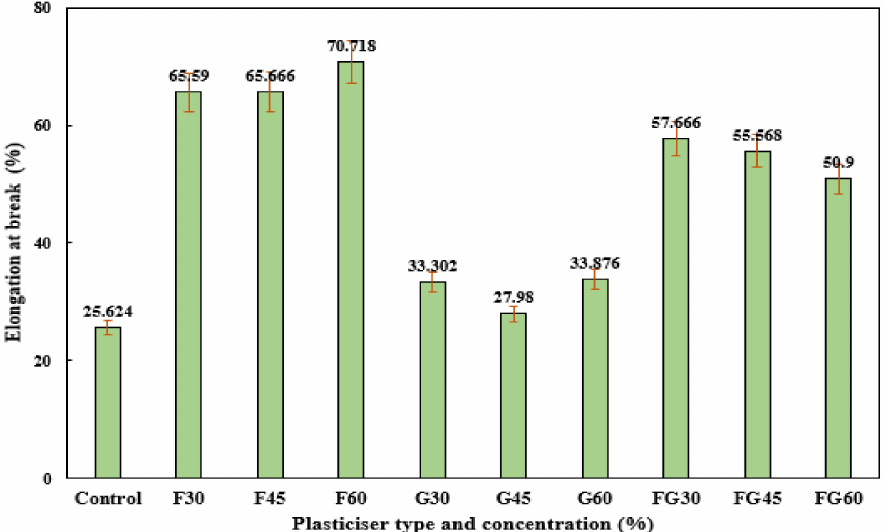
Figure 9. Extension at break of corn starch film with various plasticizer types at different concentra- tions: F30–F60: F-plasticized film; G30–G60: G-plasticized film; and FG30–FG60: FG-plasticized